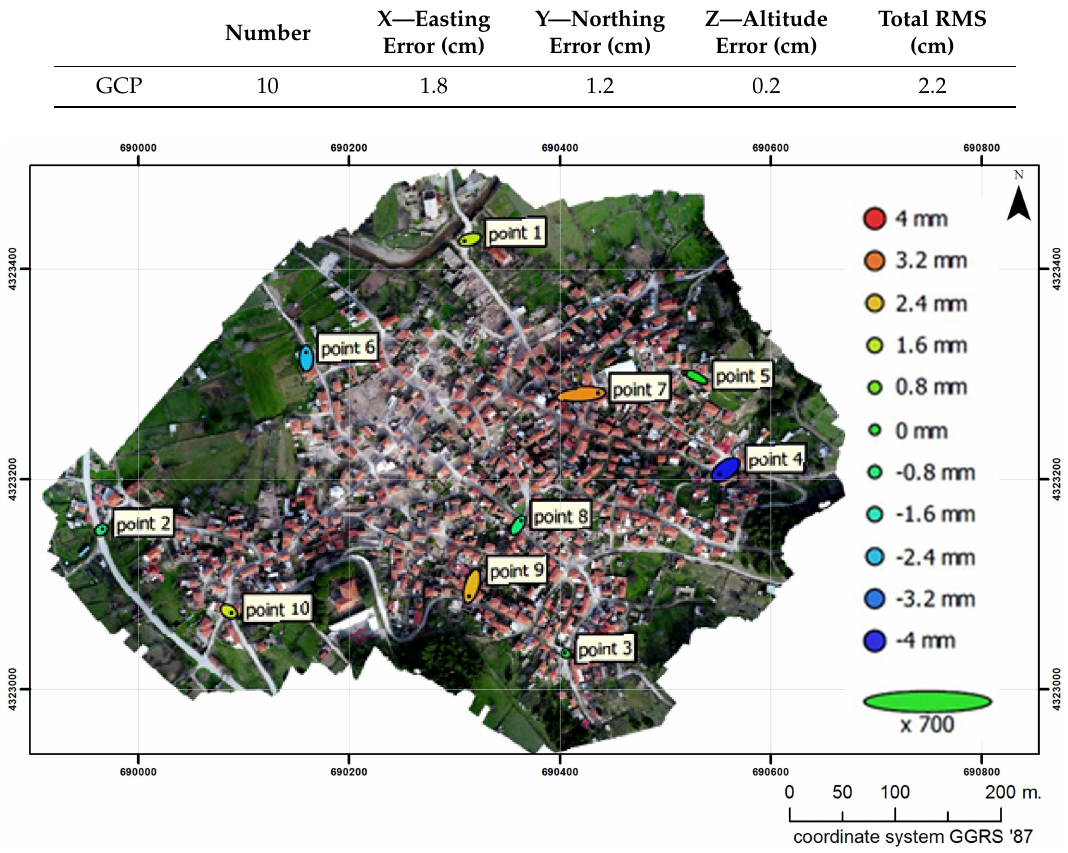
Figure 5. GCP locations and error estimates. Z error is represented by ellipse color. X,Y errors are represented by ellipse shape. Estimated GCP locations are marked with a dot. (From Photoscan / Agisoft software